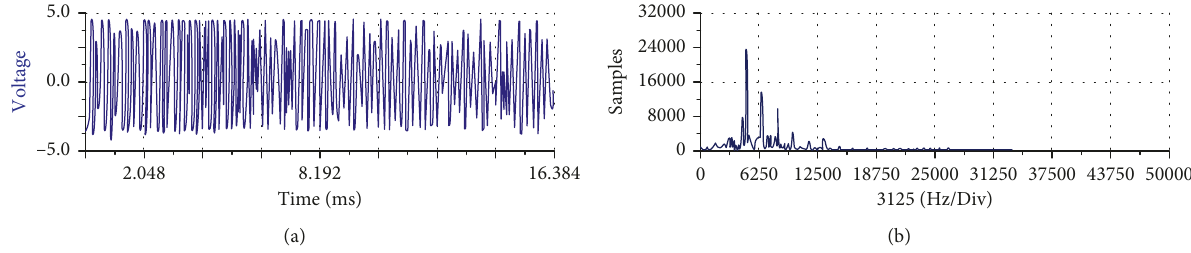
Figure 7: AE signal with serious rub impact. (a) AE waveform in the time domain. (b) AE waveform in the frequency